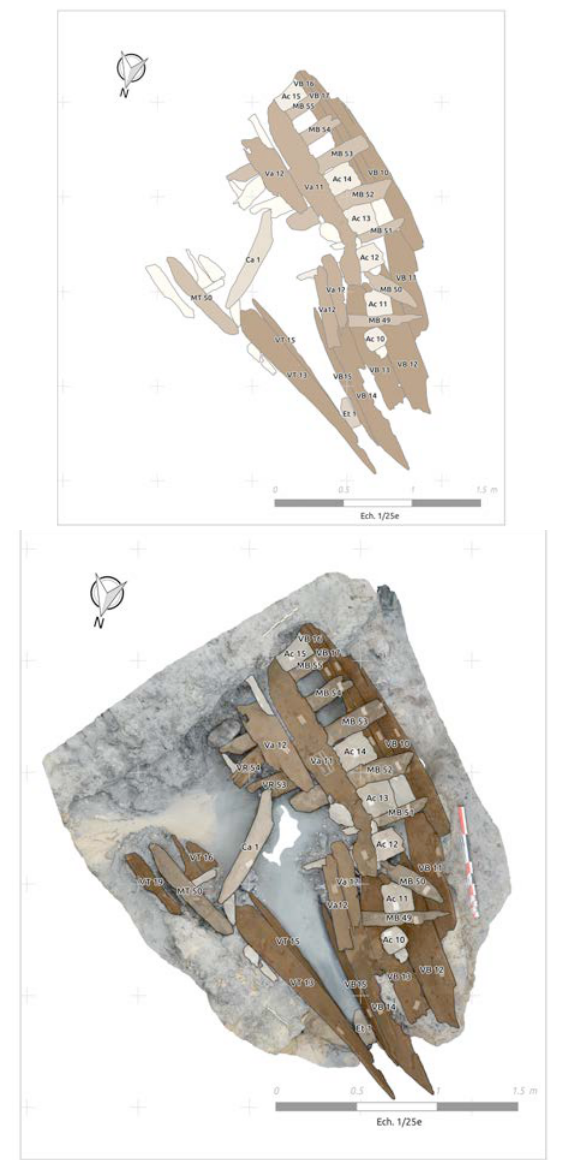
Figure 19. General planimetry (D.Dégez/Drassm) Without going into the "lidar vs photogrammetry" classic debate, it appears that the acquisition by photogrammetry allowed a better density and a very good quality texture for the 3D model. Simultaneously and for later potential applications, laser scanning has the following advantages: light independence, thin vegetation / algae penetration, minimum human dependence, fast acquisition and processing, potential high accuracy. With regard to this latter issue if there is time to scan, long stations enable a accuracy up to ± 2